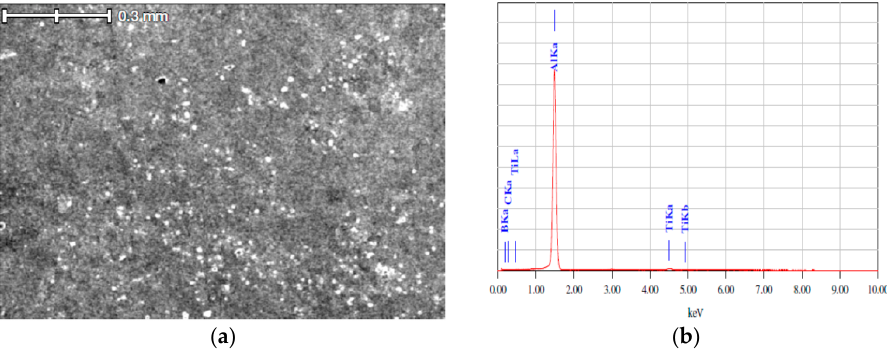
Figure 6. X ‐ ray spectroscopy (EDS) of cast Al ‐ 5%TiB 2 sample corresponds to melt holding time of 20 min ( a ) region of interest for EDS analysis and ( b ) EDS spectrum.